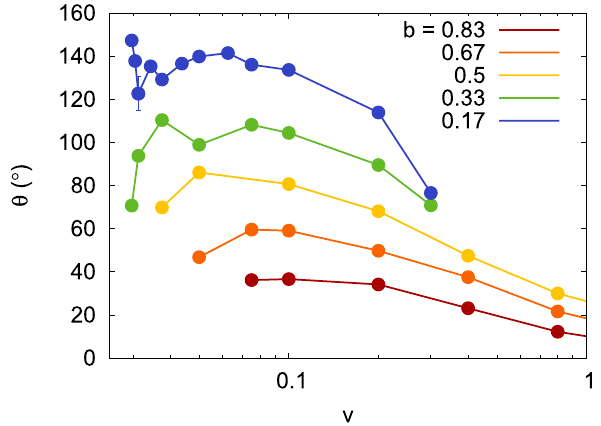
Figure 9. Deflection angle, θ , as a function of collision velocity v for several impact parameters b . Data are only shown for bouncing collision. Note the logarithmic abscissa scale.